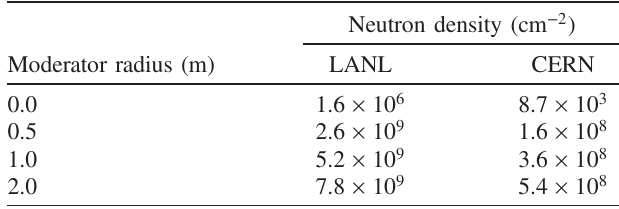
TABLE III. Neutron density for the simulated setup at two facilities: 100 μ A proton beam with 800 MeV and the small tungsten target (LANL), as well as 3 × 10 12 protons = s with an energy of 20 GeV and the large tungsten target (CERN), see Eq.